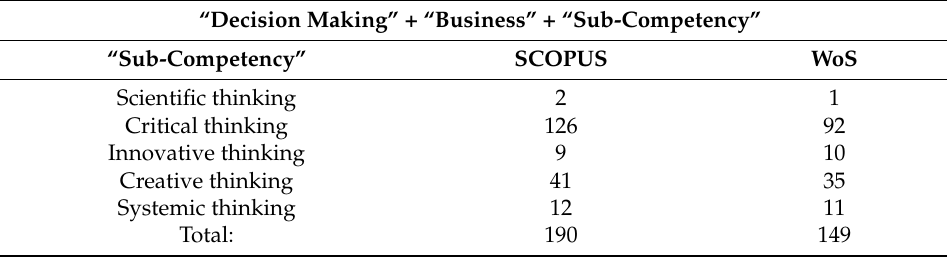
Table 5. Articles linking business decision-making and complex thinking sub-competencies.